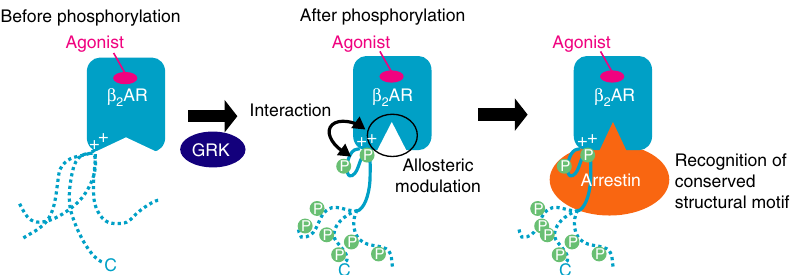
Fig. 6 Role of the phosphorylation of the C-terminal region in signal transduction. In the unphosphorylated state, the C-terminal region of β 2 AR is unstructured. Upon phosphorylation by GRKs, the TM-proximal region of the C-terminal region of β 2 AR adheres to the cytoplasmic face of the TM region, and the intracellular halves of the TM helices become spatially rearranged, which preferentially activates arrestin-mediated signal transduction. The adhesion of the phosphorylated C-terminal region to the TM-region and the spatial rearrangement of the TM helices would generate the structural motif for β